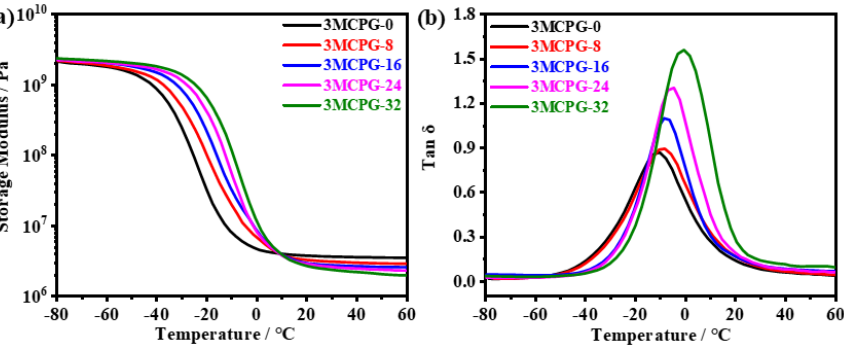
Figure 10. DMA curves of the MPU/AO-80 composites: variation in the ( a ) storage modulus and ( b ) loss factor as a function of temperature.